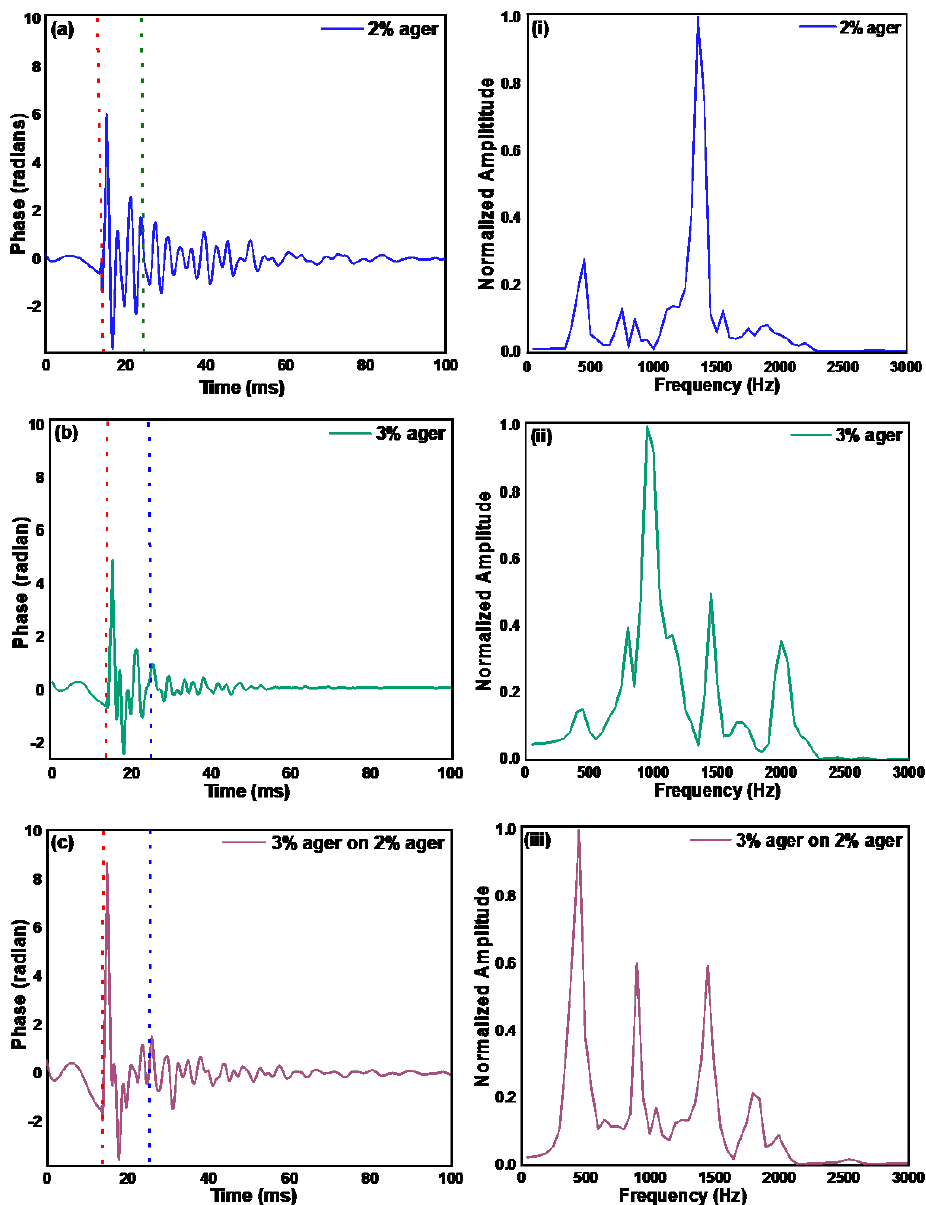
Figure 5. Displacement in terms of phase measured using pulsed excitation in ( a ) monolayer 2%, ( b ) monolayer 3%, and ( c ) dual layer 3% on 2% ager phantom. The first dotted red line represents the start of the excitation pulse and the blue dotted line represents the starting time from where the data were considered for calculation of the resonant frequency. The spectrum of the data after the blue dotted line in ( a – c ) is shown in ( i – iii ), respectively.